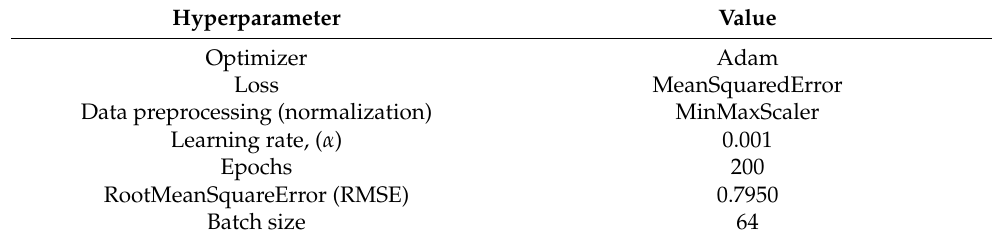
Table 2. Training hyperparameters.